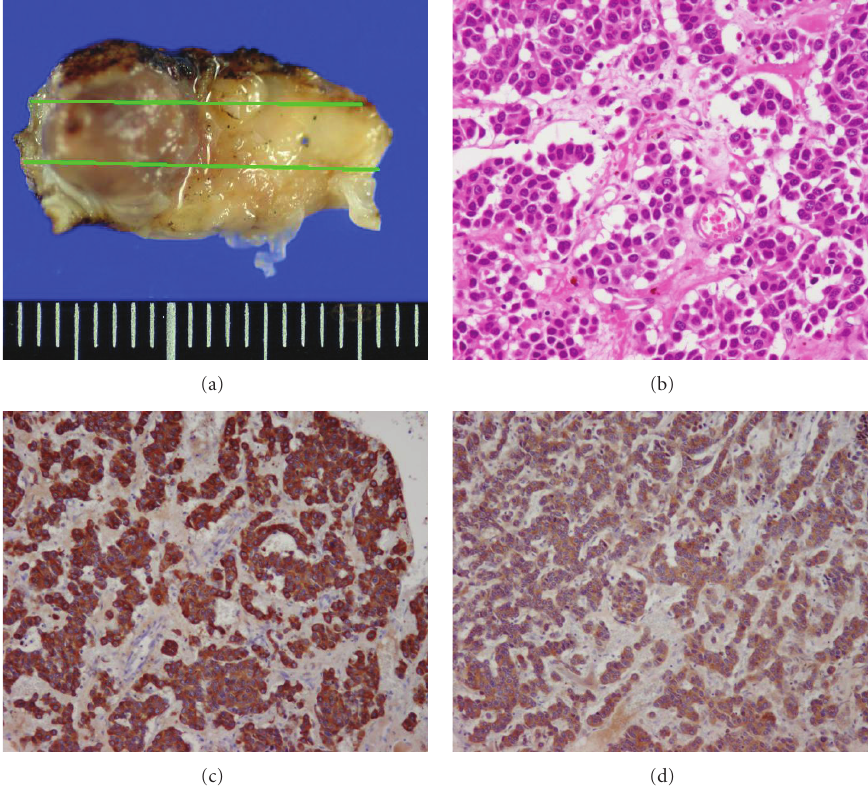
Figure 3: Histopathological findings. (a) Visual findings. An uneven tumor could be seen in the submucosa. Lines in the figure show the cross-sections used for specimen preparation. (b) Hematoxylin-eosin staining × 200. Tumor cells exhibit the so-called carcinoid pattern. Cell division was extremely low, at 1/10hpf, and no vascular invasion or tendency to invade surrounding tissue was seen. (c) Chromogranin A × 100. Tumor cells were strongly positive. (d) Synaptophysin × 100. Tumor cells were strongly